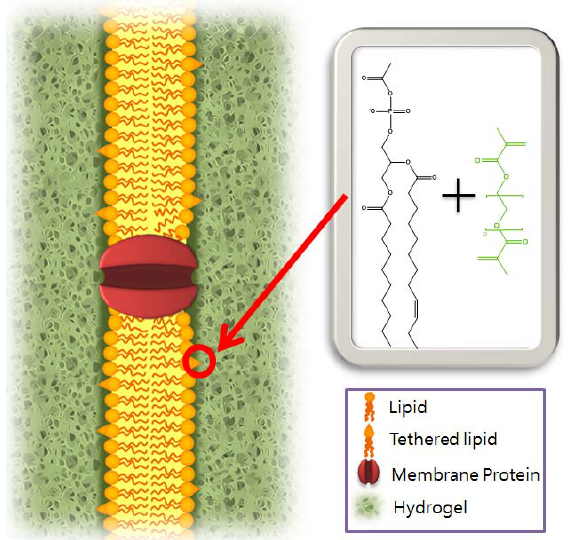
Figure 1. When a hydrogel crosslinks with the head group of a modified lipid, the bilayer is covalently linked to the surrounding hydrogel matrix (right)